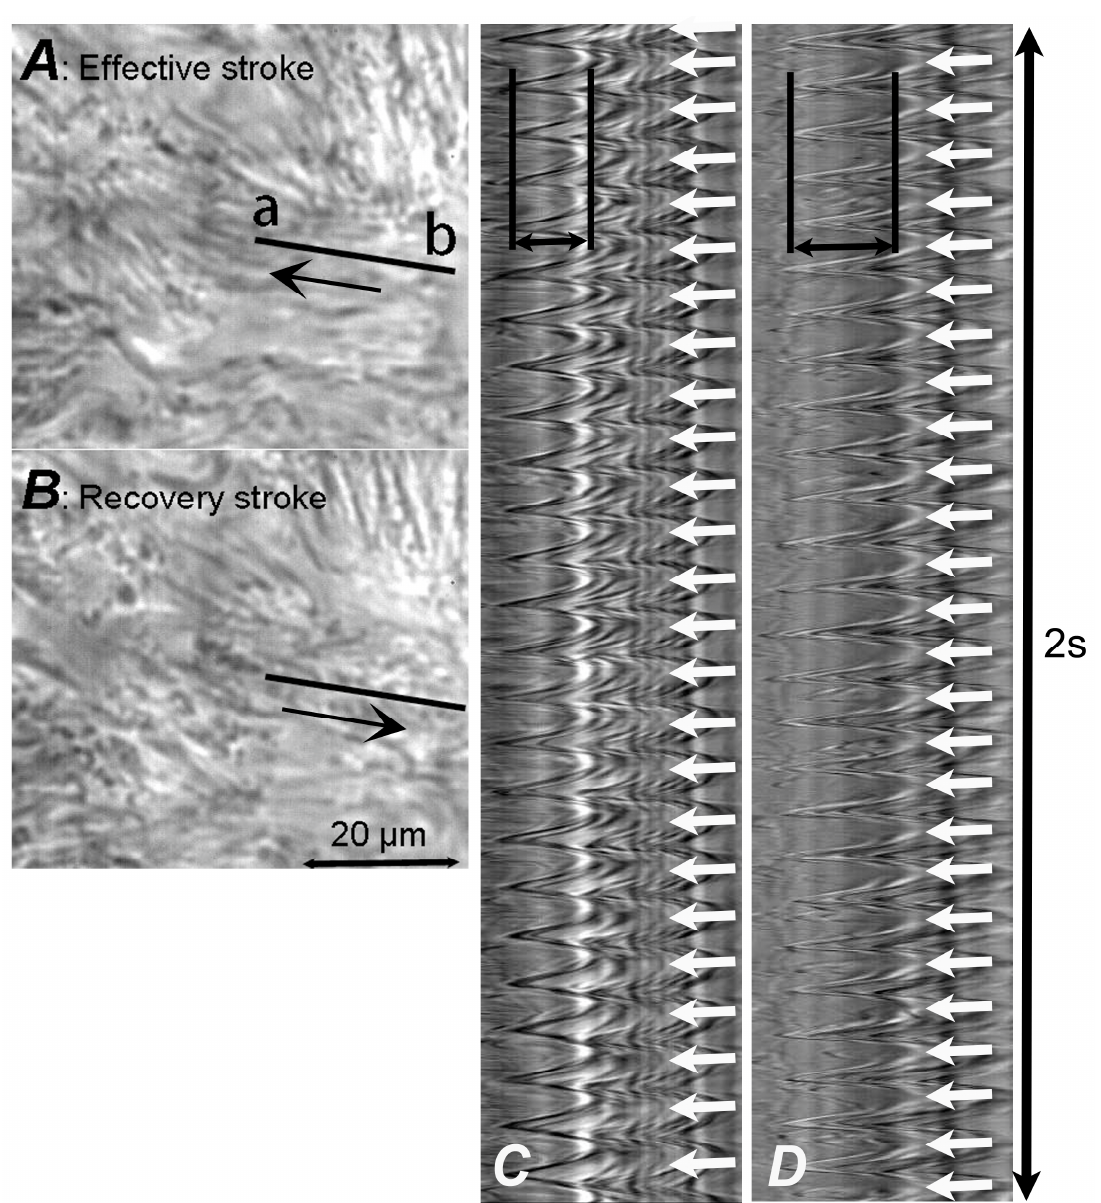
Figure 1. Video frame images of ciliated human nasal epithelial cells (cHNECs) recorded using high-speed video microscopy (500 fps) and images showing changes in the light intensity returned from the image analysis programme. ( A , B ) Video frame images of cHNECs. Panel A shows cilia in the end position of the effective stroke and the arrow shows the direction of the effective stroke, and Panel B shows cilia in the end position of the recovery stroke and the arrow shows the direction of the recovery stroke. ( C ) The light intensity changes for 2 s on line a–b marked in panel A. The distance between two lines marked by ←→ represents the ciliary beat distance (CBD), while the number of peaks marked by ↓ represents ciliary beat frequency (CBF, 12.5 Hz). ( D ) Light intensity changes of the ciliary beating in cHNECs during stimulation with 100 µM daidzein (13 Hz). The line was placed on the same position of a cHNEC as shown in panels A and B. The traces of light intensity changes clearly show that daidzein increases CBD, but not CBF.